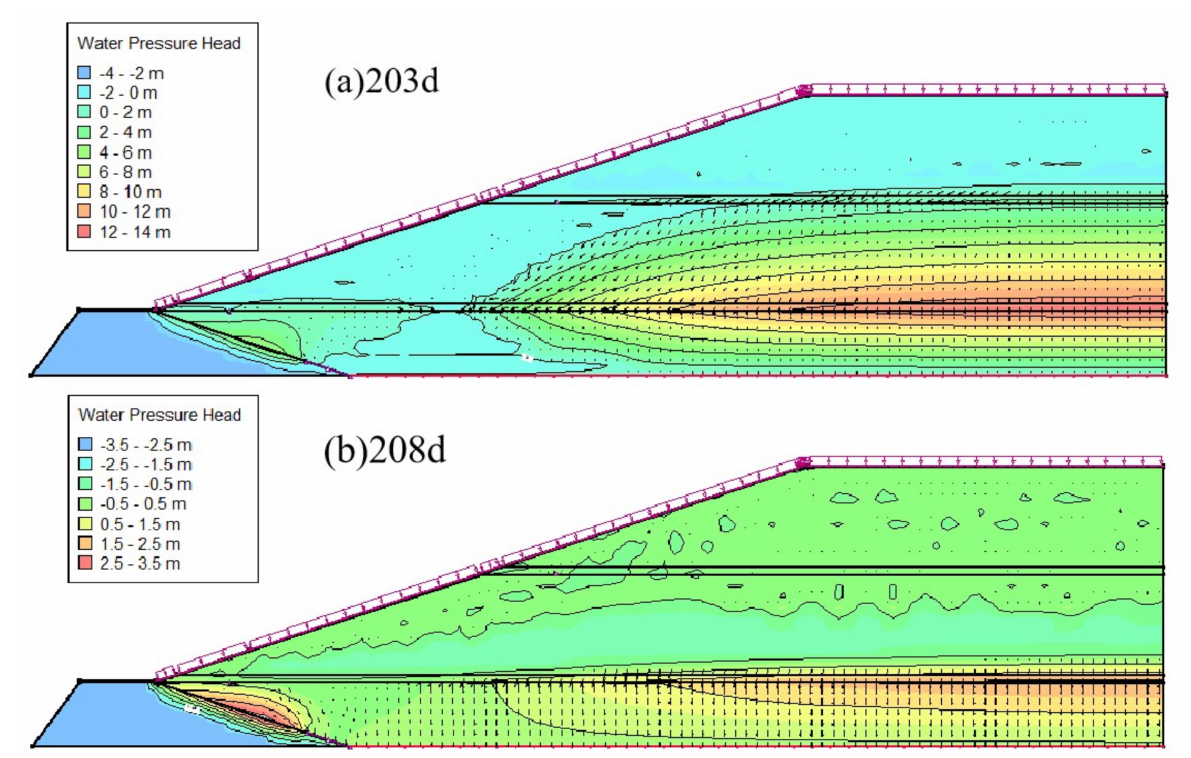
Figure 6. Leachate distribution of intermediate cover with k s of 10 − 4 cm/s during and after a rainstorm: ( a ) day 203; ( b ) day 208 day.